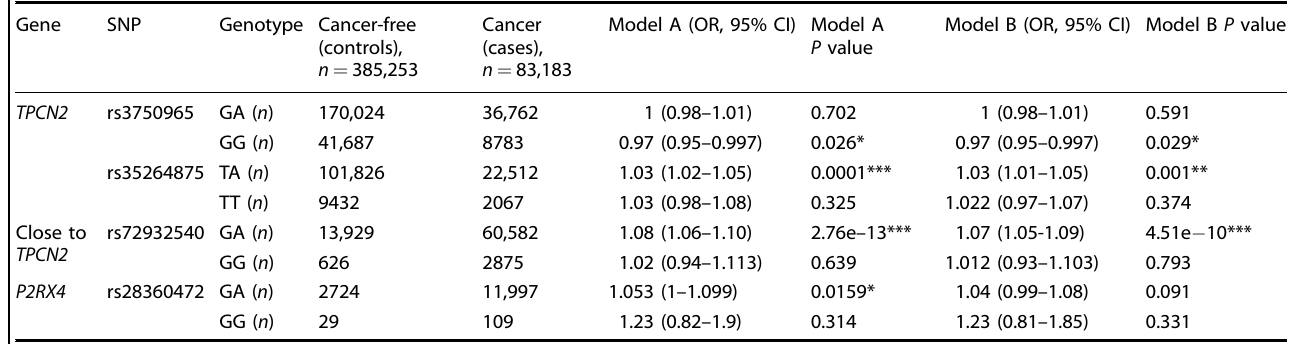
Table 2. Univariate and multivariate logistic regression analyses of genetic variants in TPCN2 and P2RX4 that are signi fi cantly associated with the risk of cancer in the UK